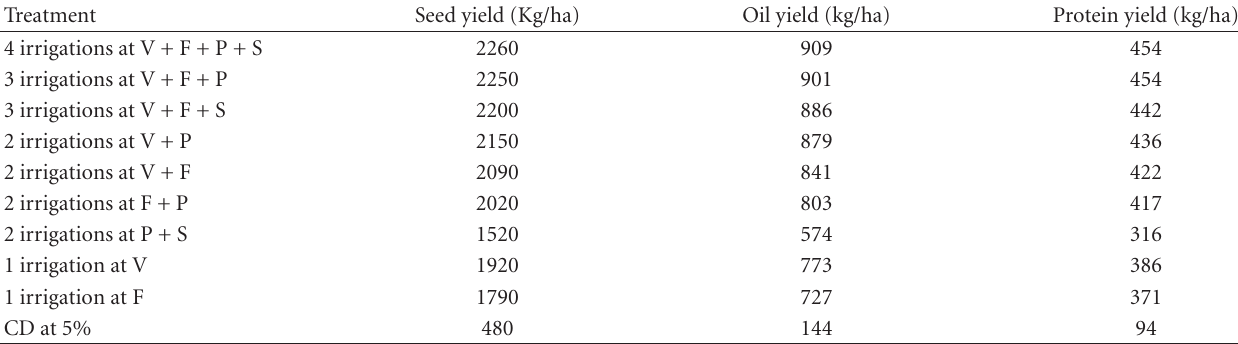
Table 10: Influence of irrigation levels and stages on seed yield, oil yield and protein yield of Indian mustard. Treatment